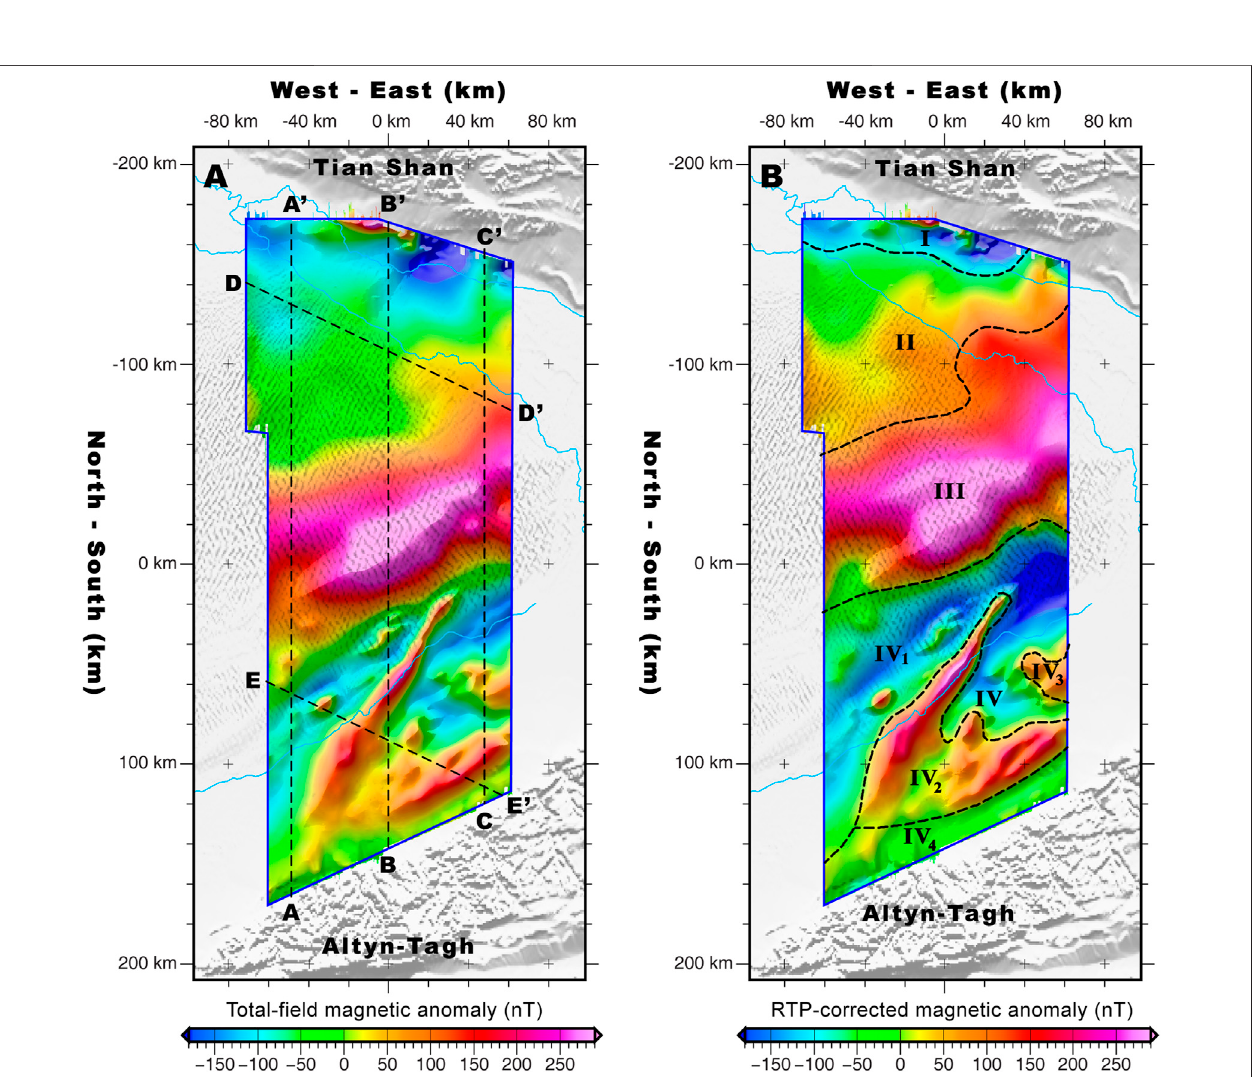
FIGURE 3 | (A) Map of magnetic anomalies (without RTP) with fi ve superimposed pro fi les used for forward modeling, the dotted lines are the locations of pro fi les. (B) Thesubregionsandtheirmarksofmajordomainsofmagneticanomalies(RTP),thedottedlinesaretheboundariesofmajordomains.Fordetailedexplanationsofthe marks, see the text. Both maps are overlain on the shaded ETOPO model (www.ngdc.noaa.gov/mgg/global.html).